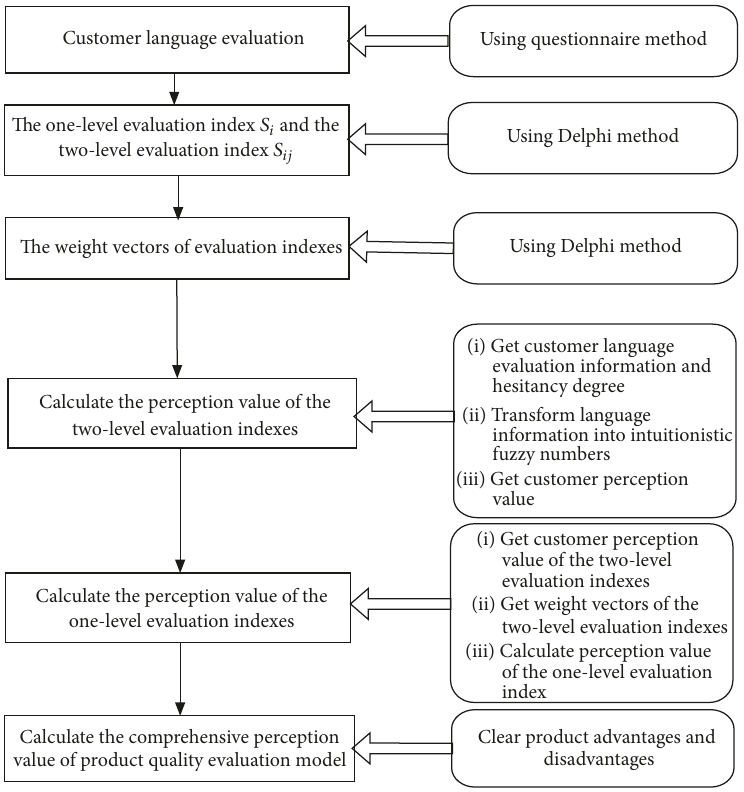
Figure 2: The framework of the proposed